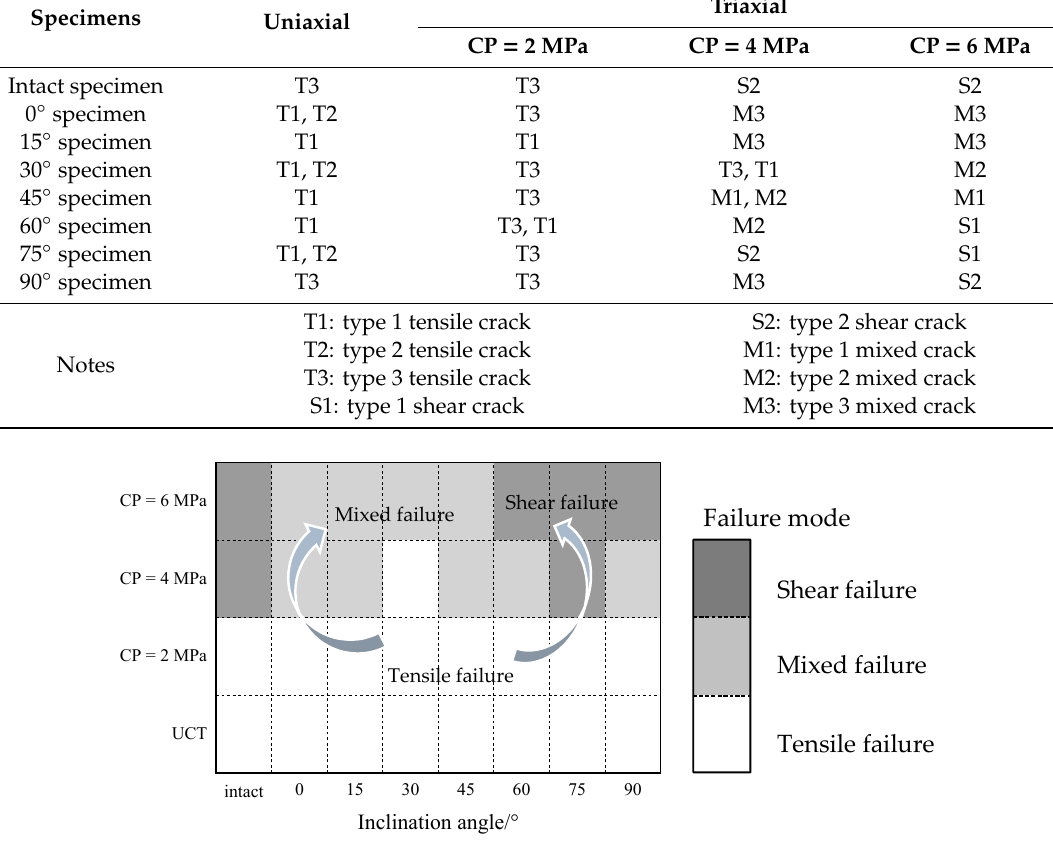
ff erent confining